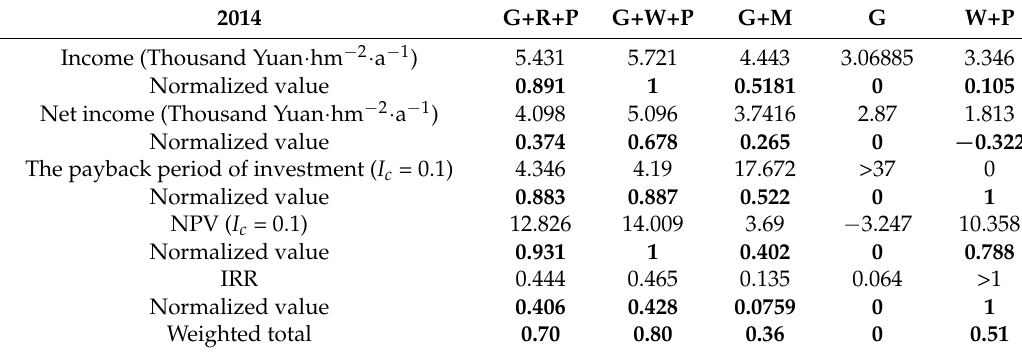
Table A5. Economic indicator values from three mixed Ginkgo systems, pure Ginkgo (G), and a cropping system (W+P), in 2014.